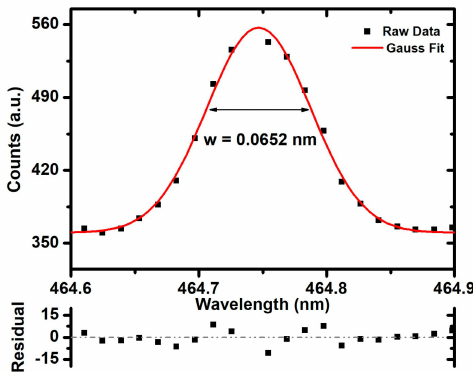
Figure 7. Doppler broadening measurement using C 2 + spectra.